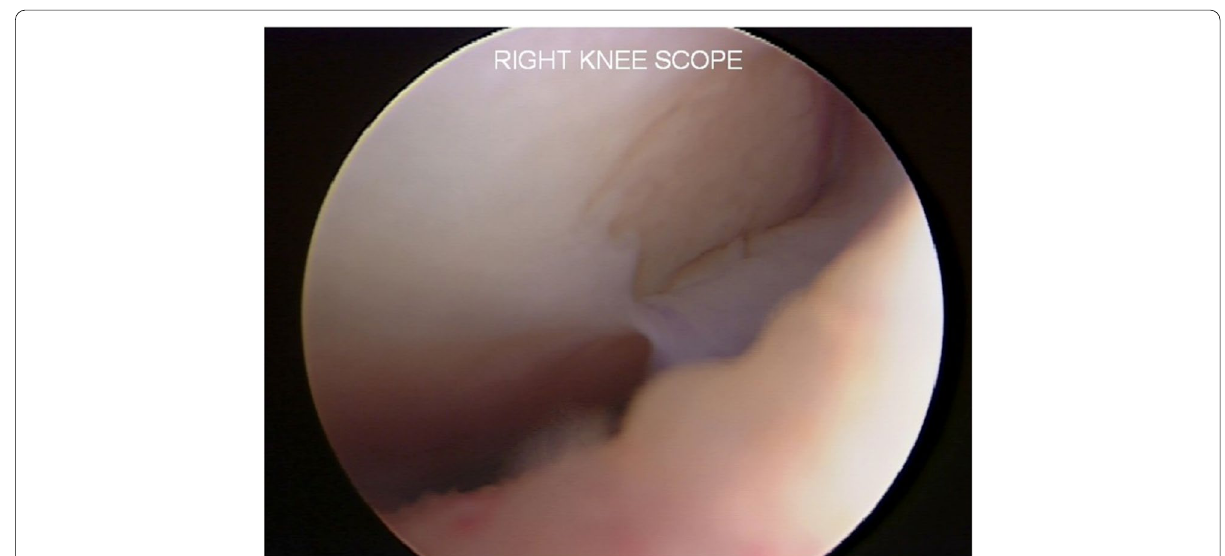
Fig. 5 Complete delamination of a large chondral defect approximately 4